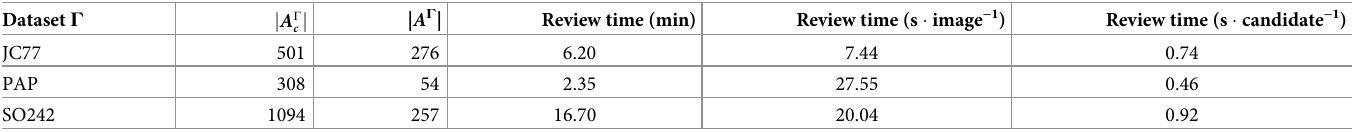
Table 2. Number of total annotation candidates A G , manually selected true positive candidates A Γ and the time it took to review them for each dataset. The review c time in s � image − 1 for A PAP has been c